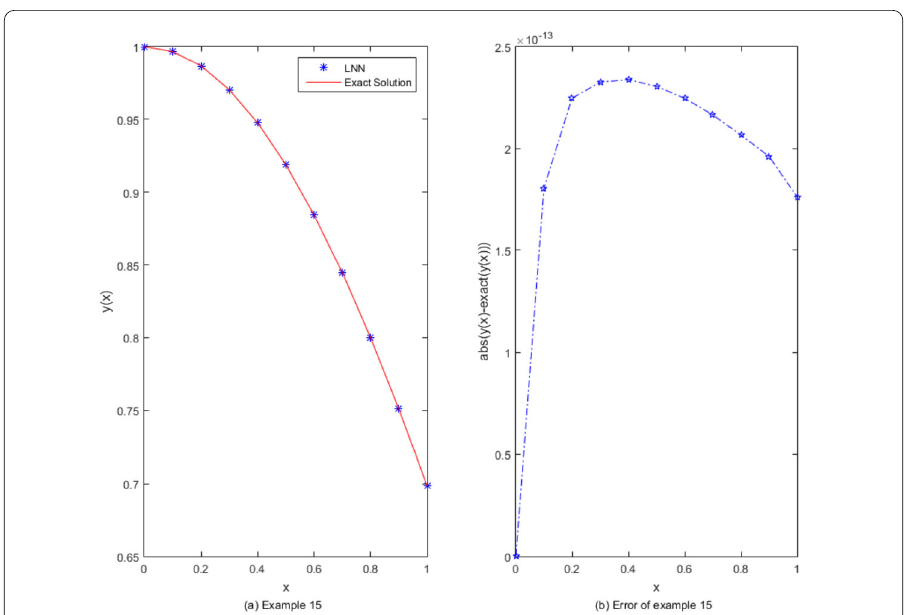
Figure 12 ( a ) Comparison between exact and LNN results; ( b ) absolute error of Example 15